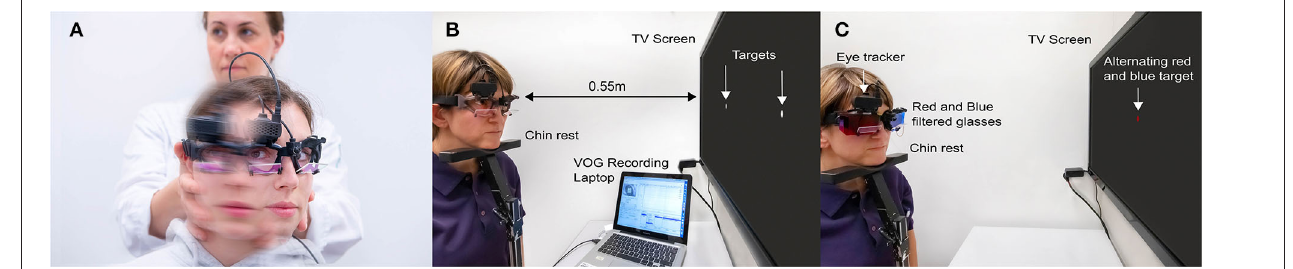
FIGURE 1 | Illustration of all parts of the Head Impulse-Nystagmus-Test of Skew (HINTS) battery by videooculography (VOG). (A) Video head impulse test, (B) videonystagmography, and (C) video test of skew.